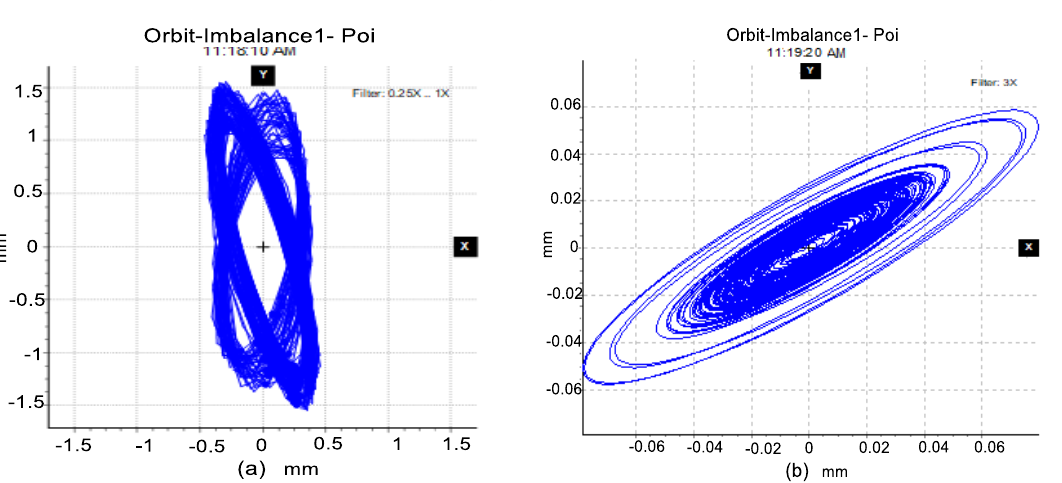
Figure 16. Experimental orbit response of the imbalanced drill string in fluid ( a ) without water and ( b ) with water.